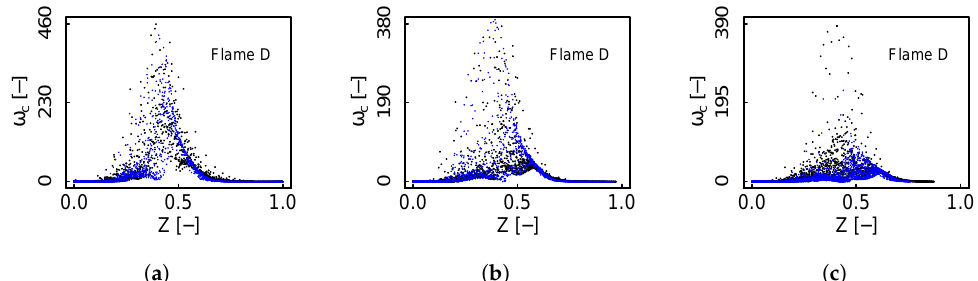
Figure 9. Progress variable chemical source term scattering at different radial sections for flame D. Black color represents non-premixed FTACLES and blue color premixed FTACLES. ( a ) x / d = 7.5; ( b ) x / d = 15; ( c ) x / d = 30.